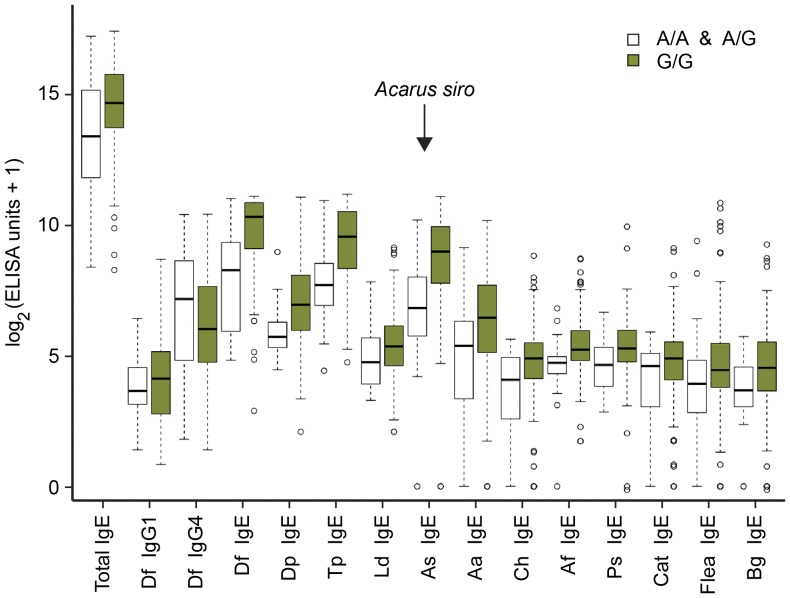
ELISA measurements of 15 immunological phenotypes depending on the genotype at SNP BICF2S2297212.The G-allele at this SNP was associated with the allergen-specific IgE response to A. siro. Note that dogs with the homozygous G/G genotype show a consistent trend for higher IgE levels across all measured antigens. Boxes represent the 25th and 75th percentile of the phenotypic distribution with the median indicated by a solid horizontal line. The whiskers indicate the minimum and maximum of the distributions. Outliers that are more than 1.5 times the interquartile range away from the median are shown as open circles. Abbreviations for allergens: Df, Dermatophagoides farinae; Dp, Dermatophagoides pteronyssinus; Tp, Tyrophagus putrescentiae; Ld, Lepidoglyphus destructor; As, Acarus siro; Aa, Alternaria alternate; Ch, Cladosporium herbarum; Af, Aspergillus fumigates; Ps, Penicillinum sp.; Cat, cat epithelium; Flea, flea saliva; Bg, Blattela germanica.